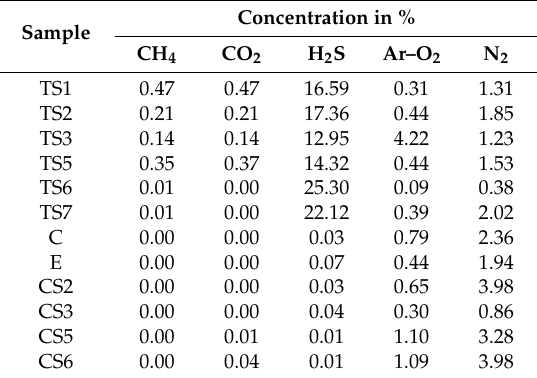
Table 8. The concentration of NCG from the dissolved gas